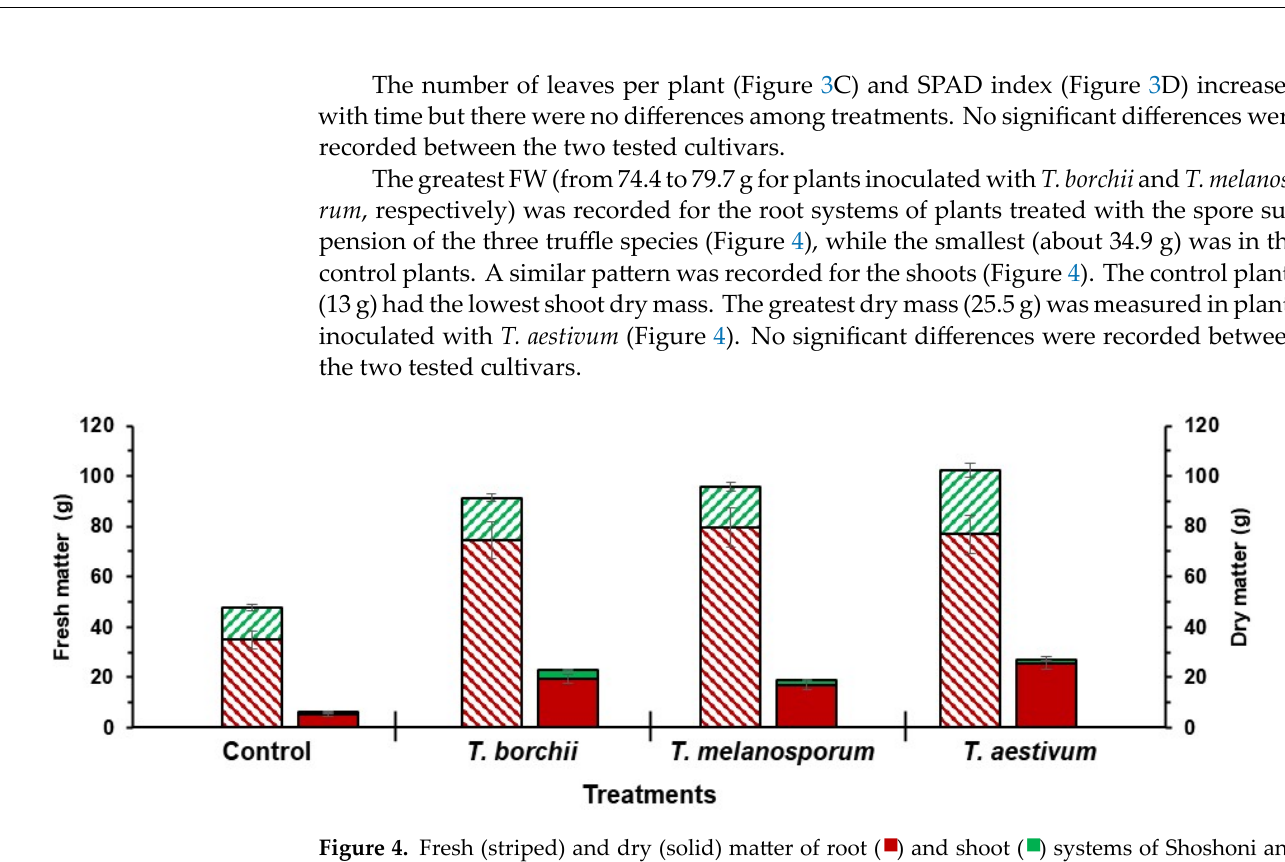
Figure 4. Fresh (striped) and dry (solid) matter of root ( ) and shoot ( ) systems of Shoshoni and Shawnee seedlings after six months of treatments with water (Control), Tuber borchii, T. melano- sporum or T. aestivum . Each value is the average of 3 replications ± SD.